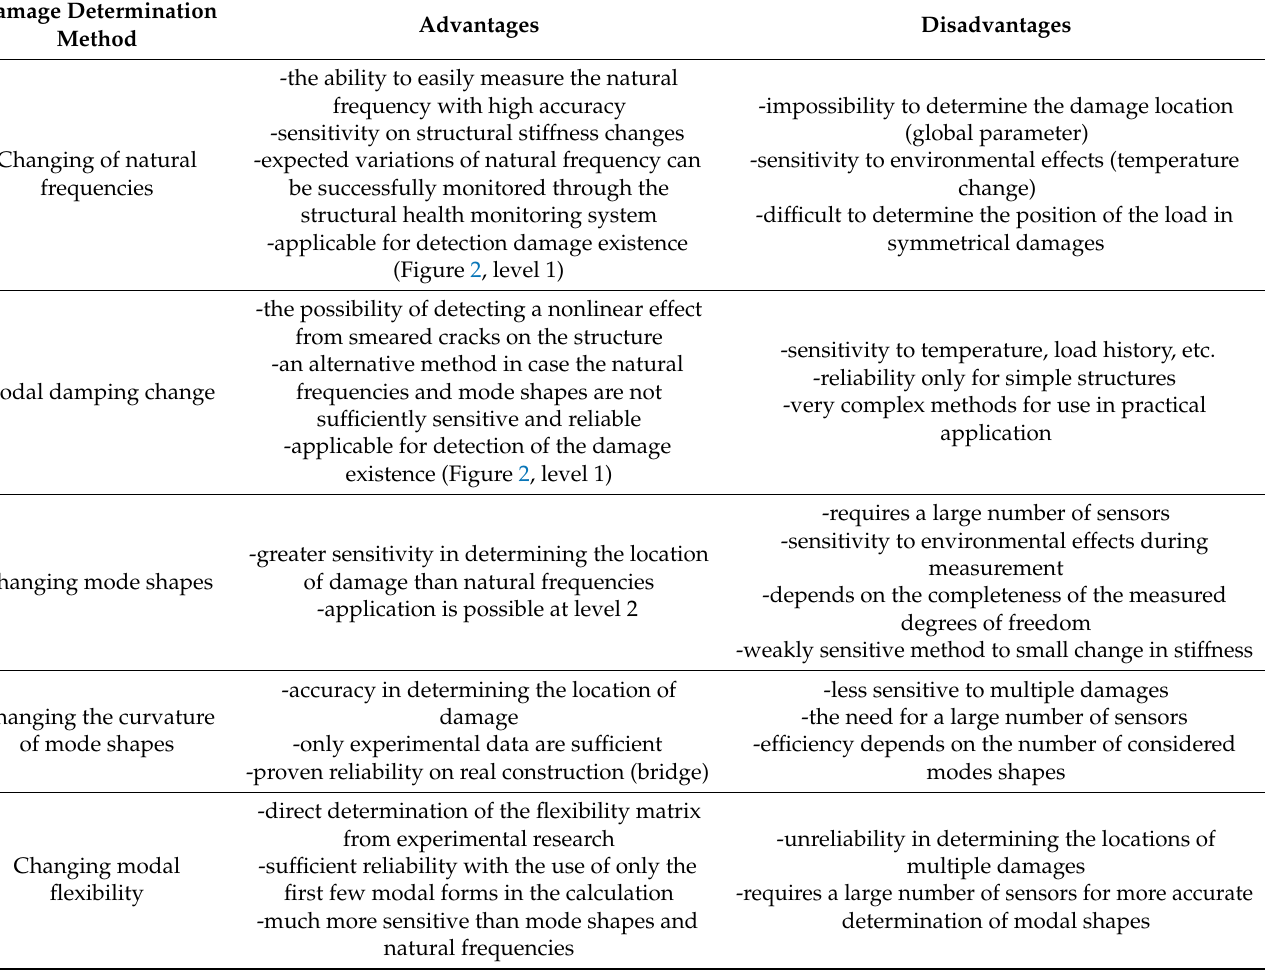
Table 1. Overview of advantages and disadvantages of damage